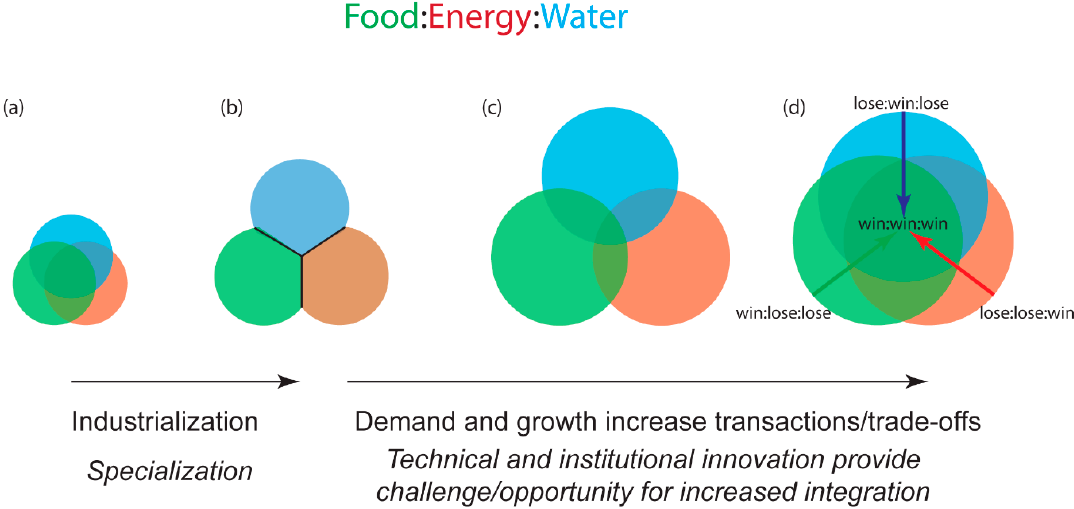
Figure 2. Evolution of the food–energy–water nexus (FEW). ( a ) Individuals acting as integrated FEW systems making resource acquisition decisions, where costs, benefits, and trade-offs are evaluated on immediate scales with relative integration. ( b ) As the FEW system evolves, specialization within sectors increases, with some degree of transaction of resources across boundaries. This is anticipated to correlate with increases in production efficiencies, but at the potential cost of integration. ( c ) As system level complexities increase in the face of increased demand, but with limited resources, the emergence of system-level dynamics results in functional interdependencies—illustrated here with increasing overlap. These overlaps or trade-offs are potential areas of friction in the absence of technical and/or institutional innovations that leverage potential, system-level synergies. ( d ) In the face of global limits to resource availability (total colored area = total resource availability) and increasing demand for food, energy, and water resources (the size of each circle), sustainable solutions will require leverage of potential synergies in the overlapping areas.